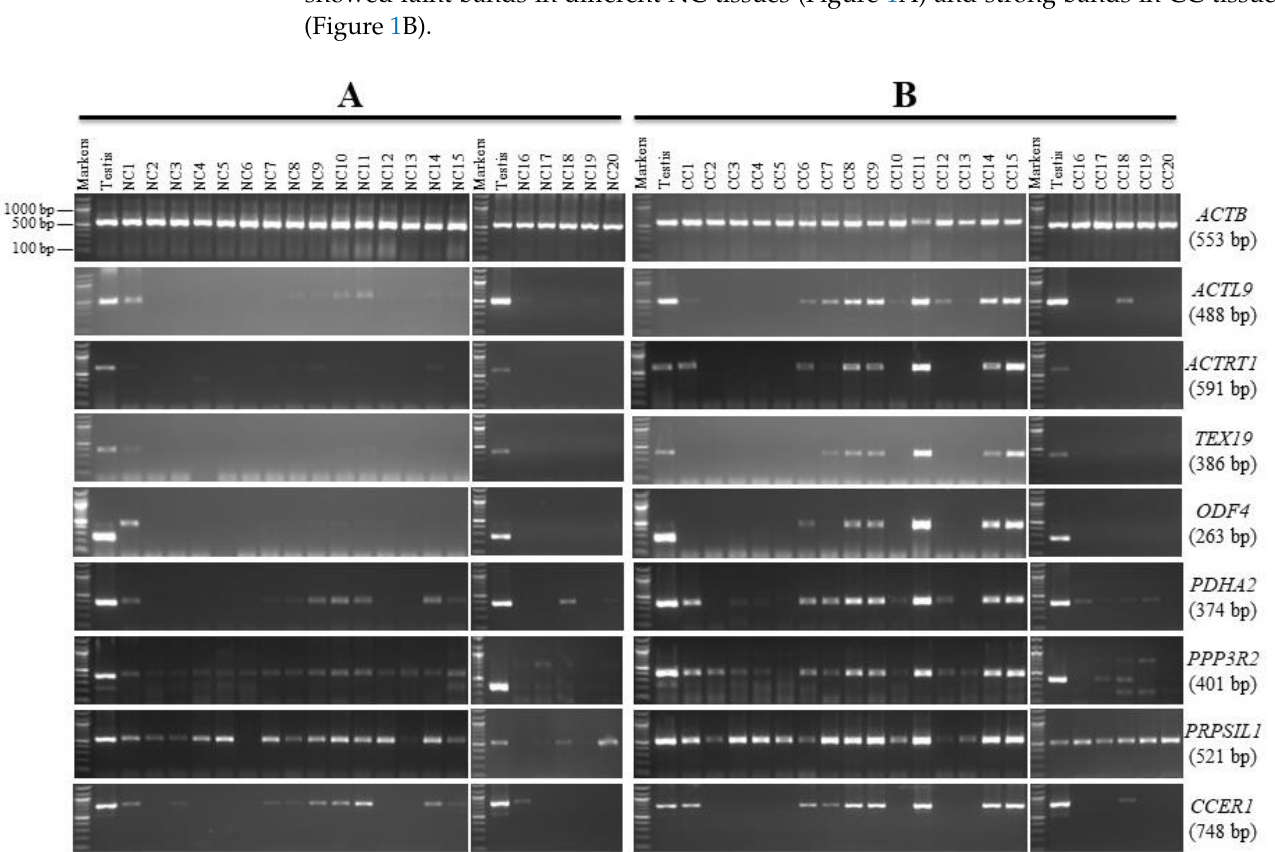
7 of 16 Table 5. Breast cancer (BC) and leukemia patients’ ages and their cancer grades.